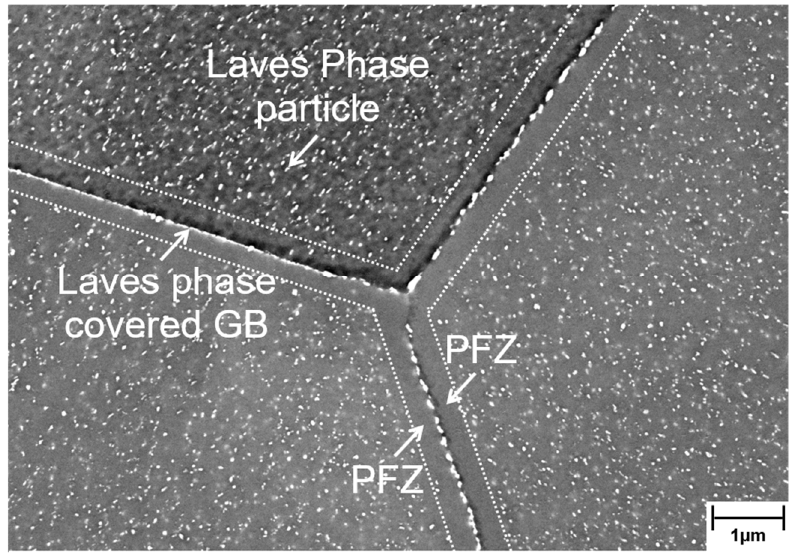
Figure 2. The microstructure of the fully ferritic Crofer ® 22 H steel in the precipitated state. PFZ, particle-free zones; GB, grain boundaries.